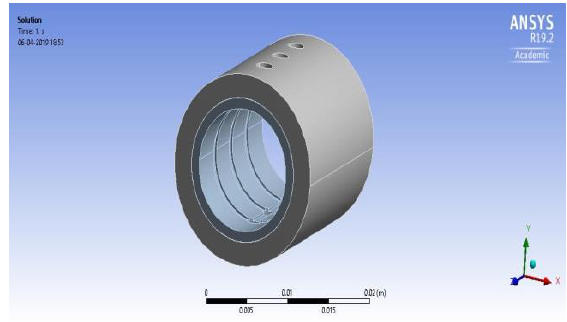
Fig. 6. Design of the bearing 1 (1